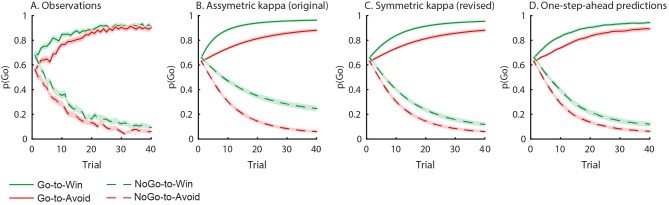
Behavioural observations and model predictions of winning base model M4.(A) Data averaged over placebo and MPH. Go responding is higher for Win than Avoid cues, independent of the action requirements. (B) Model M4 simulations from the original manuscript; the instrumental learning bias (κ) was symmetrical prior to [0 1] constraint, resulting in disproportionally strong Go-to-Win learning. (C) Revised model M4 simulations with effects of κ symmetrical in the reward and punishment domain better match the data. (D) One-step-ahead predictions for the revised model M4. The one-step-ahead predictions, which take into account all preceding choices and outcomes for predicting each, match the data even closer than the model simulations.